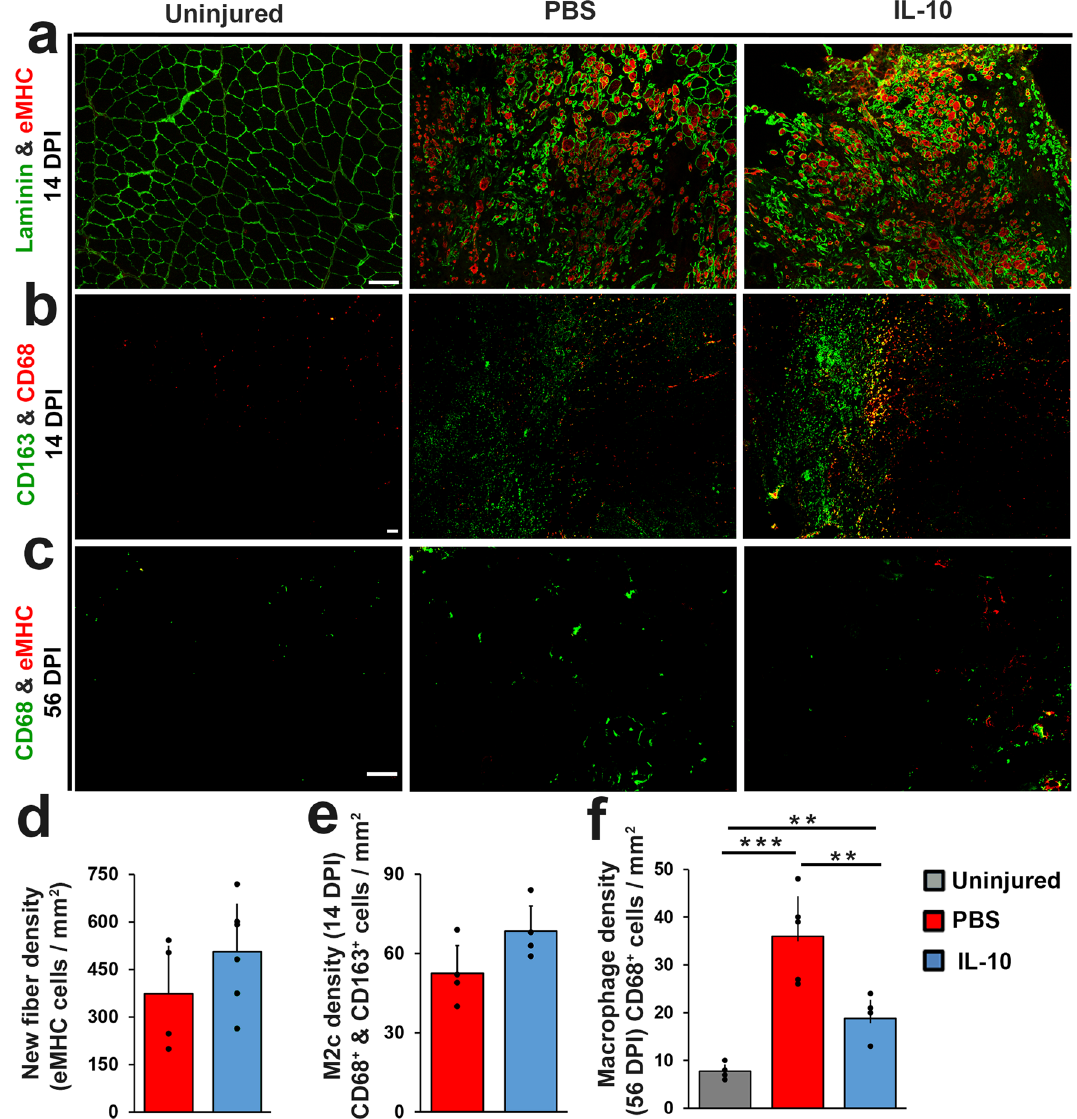
Figure 5. IL-10 delivery prolonged de novo myofiber regeneration and shortened macrophage residency delivery. TA muscle cross-sections prepared from 14 DPI tissue samples were co-stained for ( a ) CD68 (red) with CD163 (green) or ( b ) Laminin (green) with eMHC (red). ( c ) TA muscle cross-sections prepared from 56 DPI tissue samples were co-stained for CD68 (green) with eMHC (red). Scale bar = 100 µm. Immuno-stained